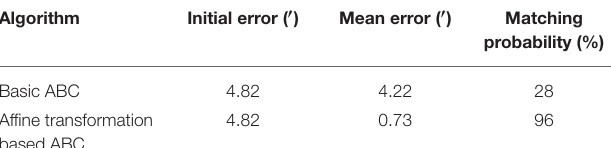
FIGURE 5 | Position errors of affine transformation based ABC. TABLE 4 | Comparison of 50 Mont Carlo simulation results between basic ABC and affine transformation based ABC.